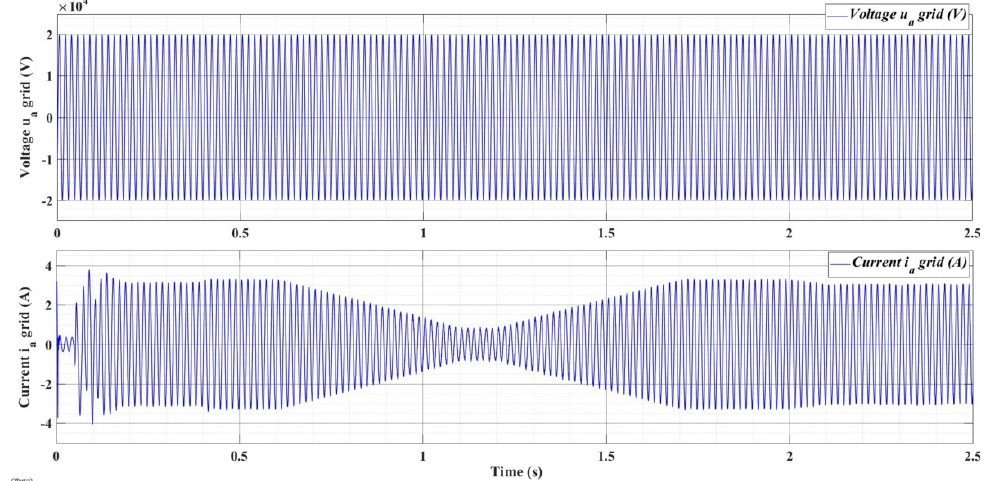
Figure 31. The time evolution of the u a voltage and i a current of the main grid (signal evolution of the type 1 PV array).